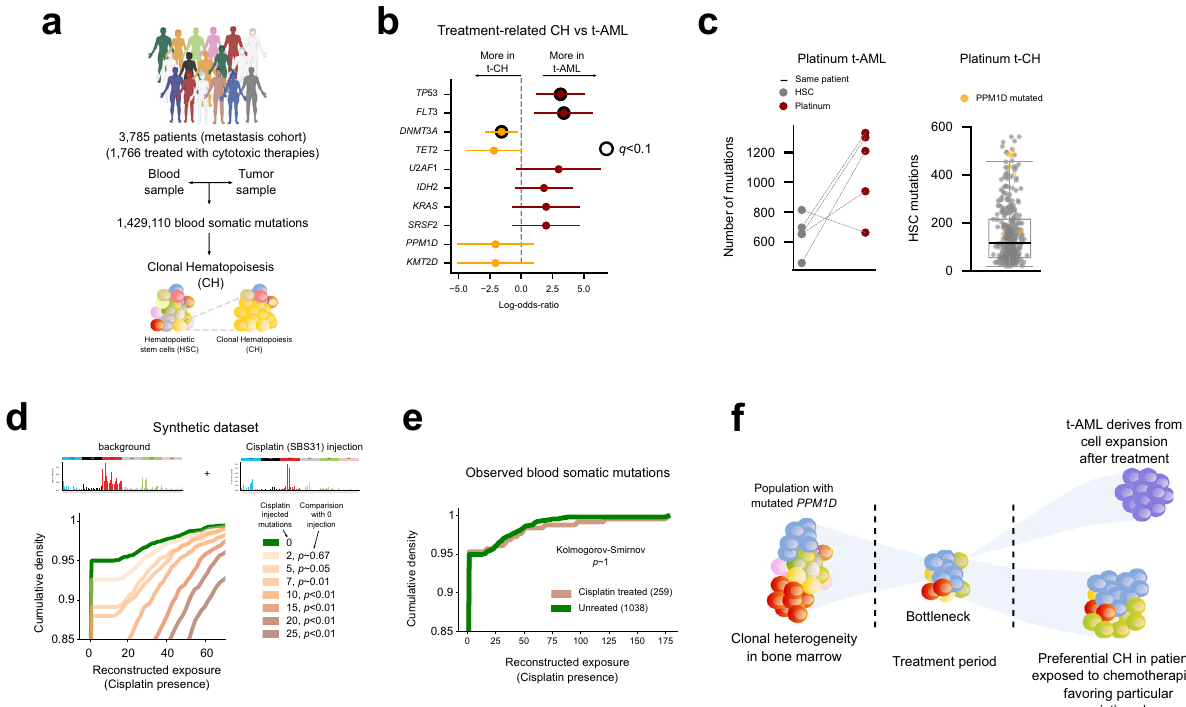
Fig. 4 The development of clonal hematopoiesis in chemotherapy-exposed donors. a Somatic mutations across blood samples from 3785 patients in the metastasis cohort were detected using the tumor sample as reference of their germline genome. This identi fi cation is possible because a process of clonal hematopoiesis has occurred in these samples, rendering the mutations in the founder HSC detectable through bulk sequencing. b Overrepresentation of mutations in different genes across CH or tAML cases. The bars represent the 95% con fi dence intervals of the log-odds ratio. c Left panel: number of mutations contributed by the HSC and the platinum-related signature in tAML cases of the WGS AML cohort. Each patient is represented by a straight line joining two circles that represent the contribution of the HSC (gray) and the platinum-related (red) signatures. Right panel: distribution of the number of HSC mutations identi fi ed in blood samples across donors in the metastasis cohort. Samples carrying PPM1D mutations are highlighted in yellow. The box in the boxplot delimits the fi rst and third quartiles of the distribution (with a line representing the median); the whiskers delimit the lowest data point above the fi rst quartile minus 1.5 times the interquartile distance and the highest data point below the third quartile plus 1.5 times the interquartile distance. d To study the detectability of platinum mutations in blood samples of donors of the metastasis cohort, we generated synthetic samples with the same mutational pro fi le. Then, we injected sets of mutations of different sizes that followed the tri-nucleotide probabilities of the platinum-related signature. We then determined the distribution of the reconstructed exposure to this signature of the injected samples. The cohorts of synthetic samples injected with seven or fewer mutations exhibit a distribution of reconstructed exposure that does not differ signi fi cantly (one-tailed empirical p -value) from that of the original cohort of synthetic samples. However, the distribution of reconstructed exposure of cohorts of samples injected with 10 or more platinum-related mutations are signi fi cantly different from that of the original cohort of synthetic samples. e No signi fi cant differences (Kolmogorov-Smirnov test) are observed in the distribution of the reconstructed exposure (activity) to the platinum-related signature among platinum exposed and platinum non-exposed donors in the metastasis cohort. f Schematic diagram depicting the possible development of CH and tAML upon chemotherapy exposure of hematopoietic cells. CH clonal hematopoiesis, t-CH treatment-related clonal hematopoiesis, SBS31 platinum-related single base substitution signature, HSC hematopoietic stem